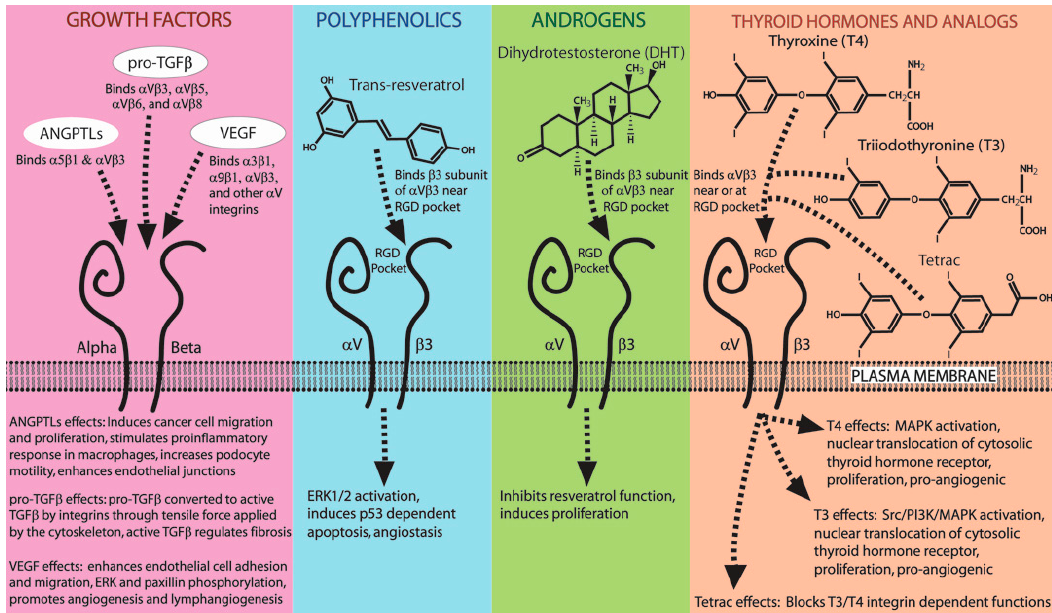
Figure 4. Integrins serve as cell surface receptors for growth factors, hormones, and small molecules. Various growth factors use integrins as cell surface receptors. Angiopoietin-like proteins